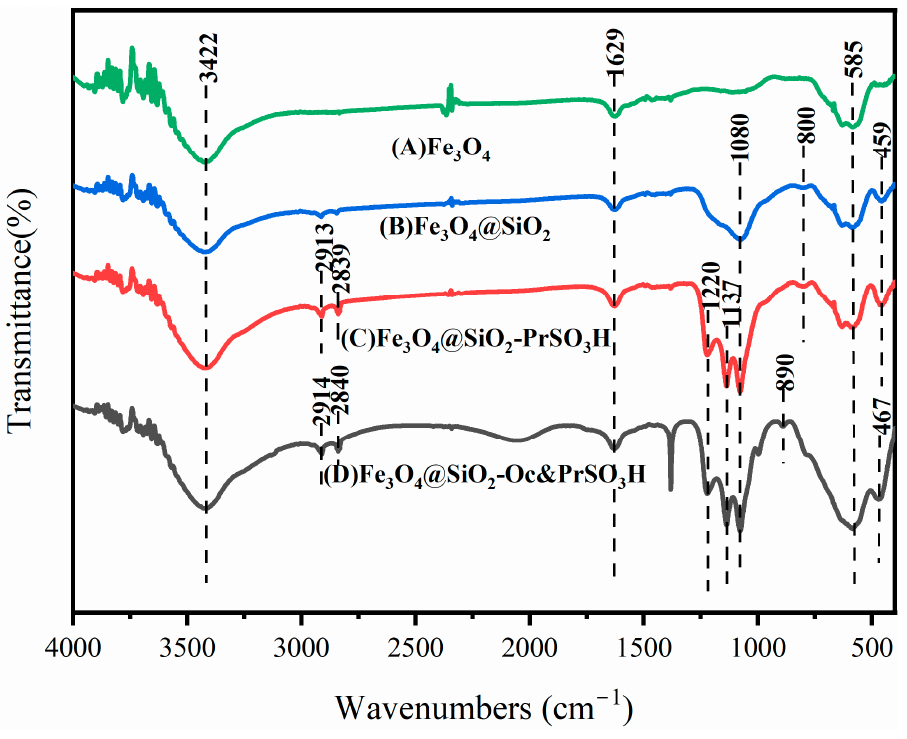
Figure 3. FT-IR spectra for ( A ) Fe 3 O 4 , ( B ) Fe 3 O 4 @SiO 2 , ( C )Fe 3 O 4 @SiO 2 -PrSO 3 H and ( D ) Fe 3 O 4 @SiO 2 -